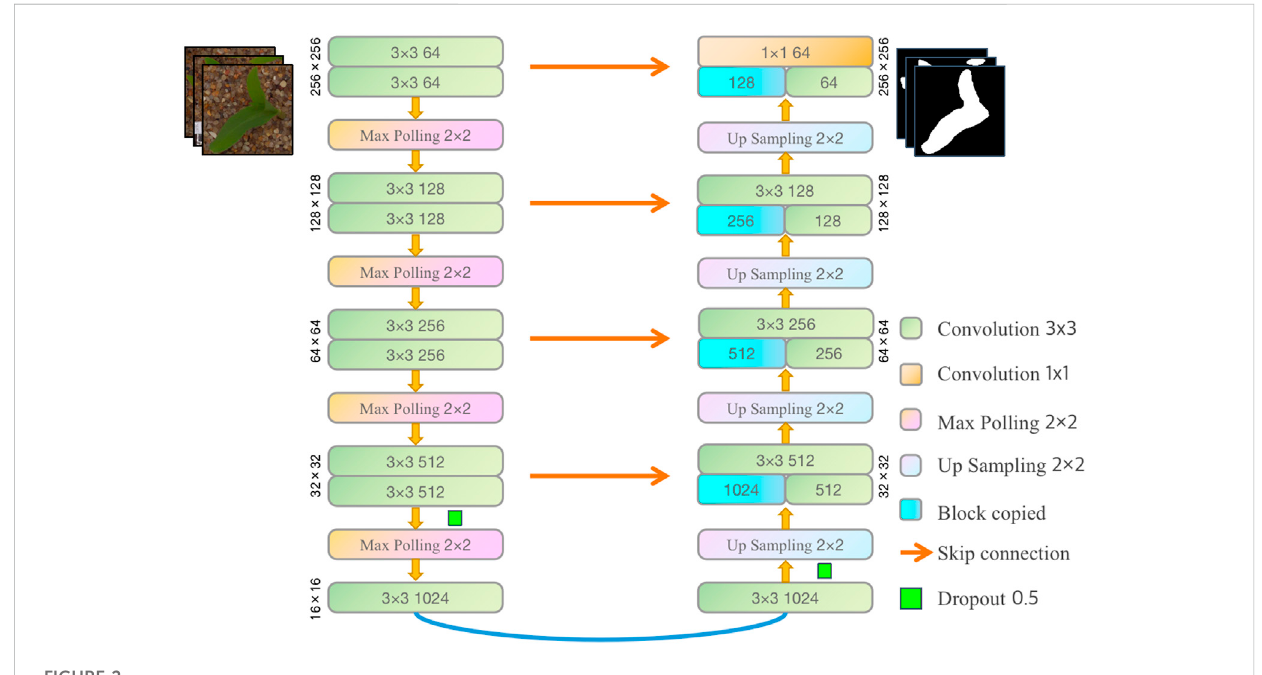
FIGURE 2 Model architecture diagram.